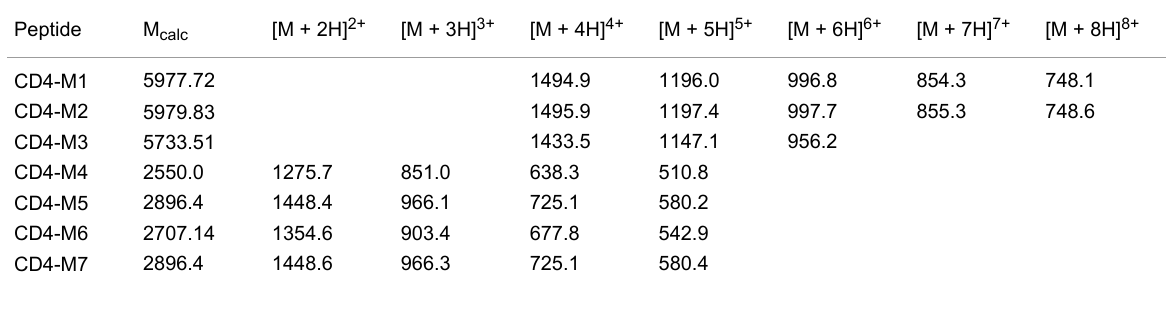
Table 2: ESI-mass spectrometry data of peptides.